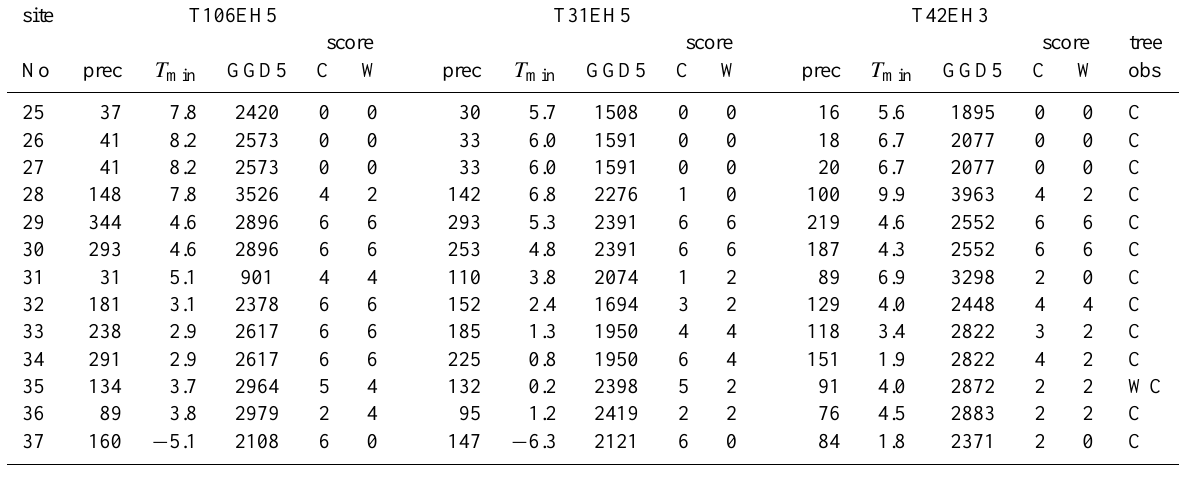
Table 8. Summary of all simulations for marine sites using JJA precipitation, minimum temperature ( T min ) and growing degree days above 5 ◦ C (GDD5). Only maximum values within a distance ± 3 grid points are given for each variable.